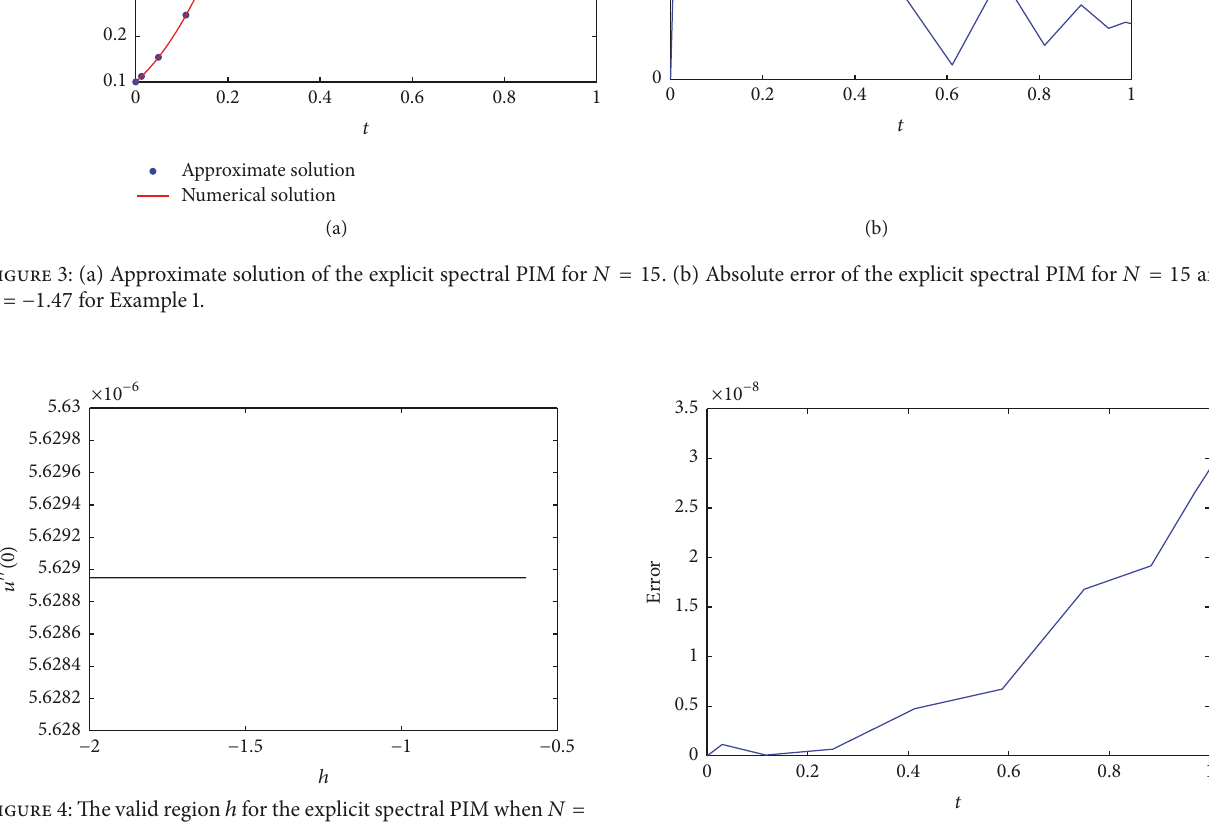
Figure 6: Absolute error of the explicit spectral PIM for 𝑁 = 10 and ℎ = −1.1 for Example 2.